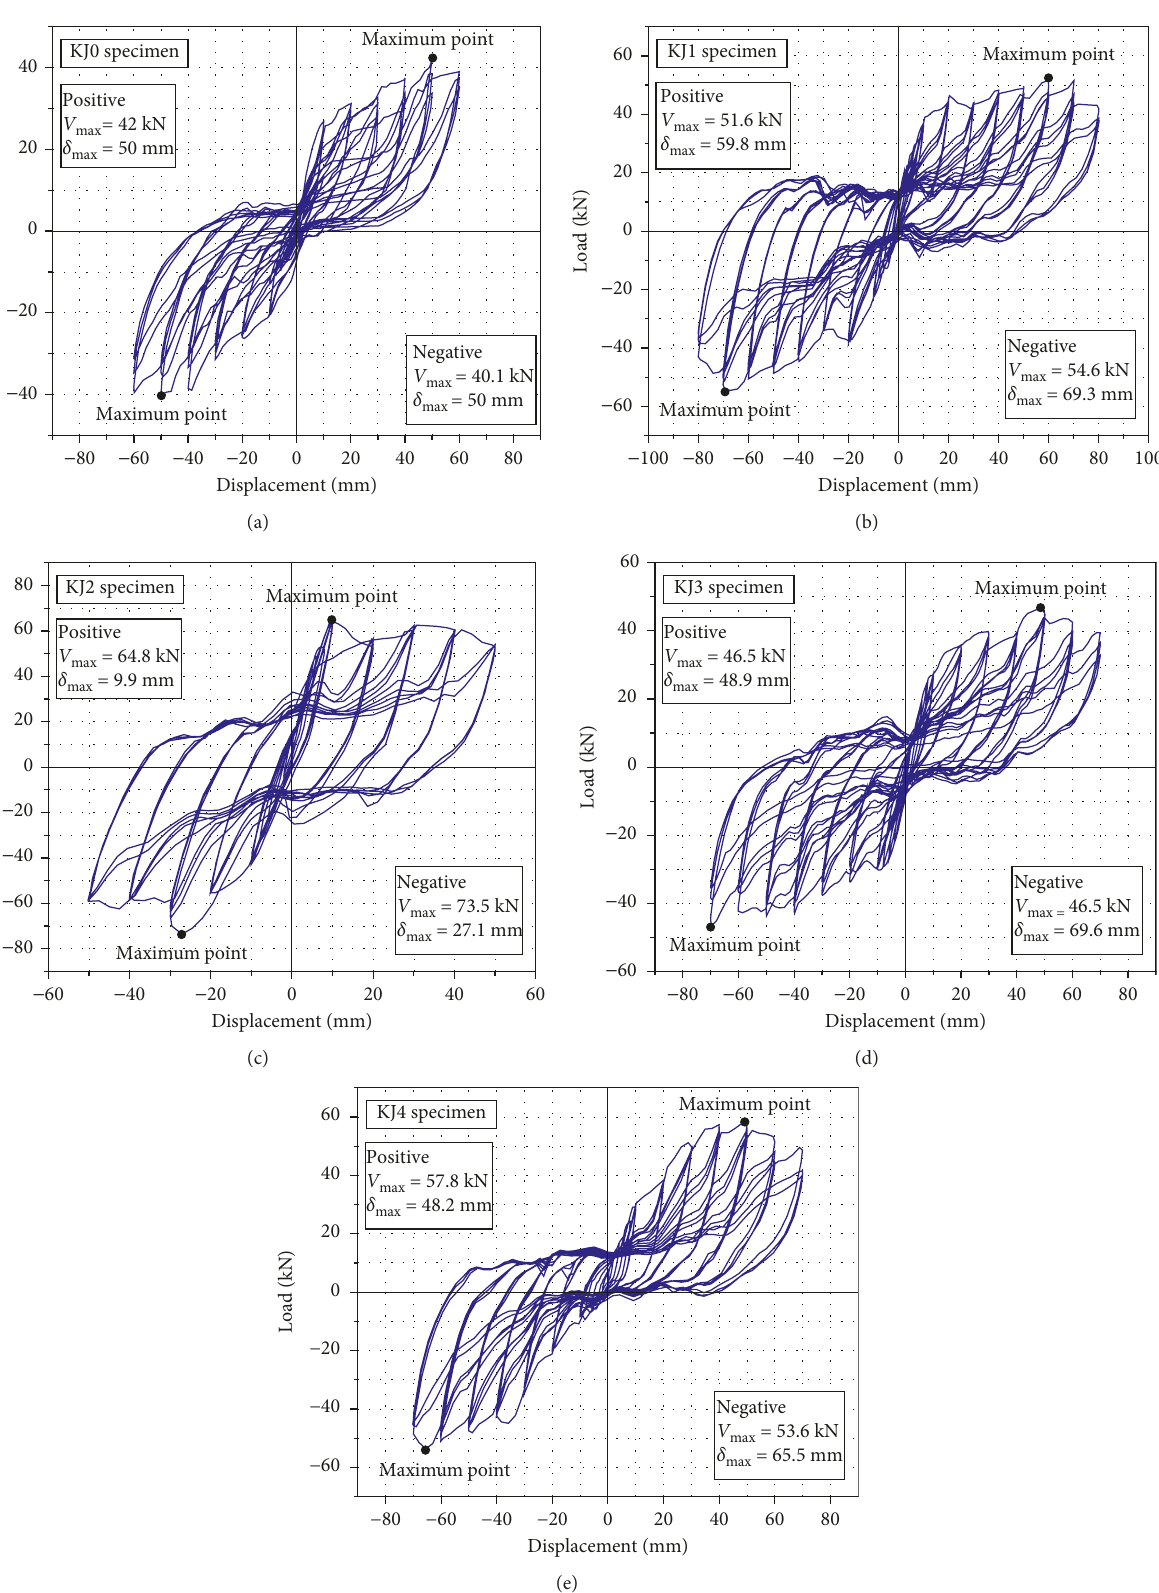
Figure 7: Hysteretic curves. (a) KJ0, (b) KJ1, (c) KJ2, (d) KJ3, and (e)